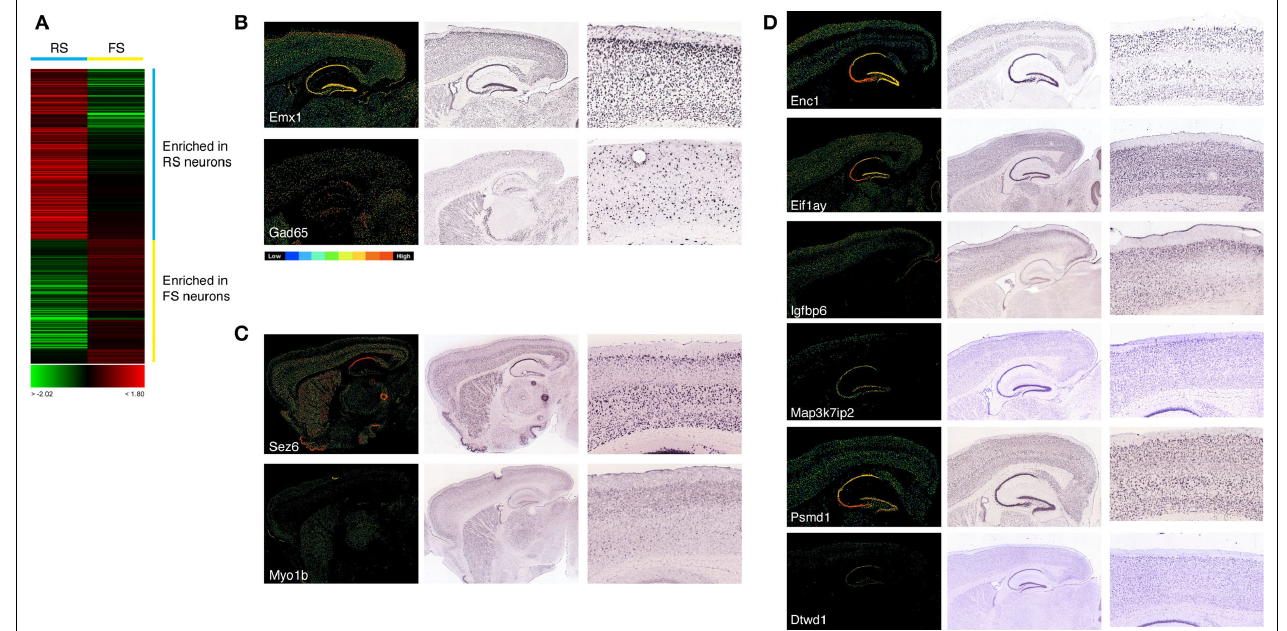
FIGURE 6 | (A) Clustering of transcripts identifi ed by t -test as enriched in either RS or FS cells. Expression is represented by a scale from green (enriched in FS cells) through red (enriched in RS cells). Each row represents expression for a single gene. (B) In situ hybridization patterns for the pyramidal neuron-specifi c transcript Emx1 and the GABAergic interneuron-specifi c transcript Gad65. Low power images are shown of mRNA in situ hybridizations of a set of differentially expressed genes on parasagittal sections of the adult mouse brain, from the Allen Brain Atlas (mouse.brain-map.org), along with a high power image of the expression in the somatosensory cortex. In all images the olfactory bulbs are to the left and the cerebellum to the right. For